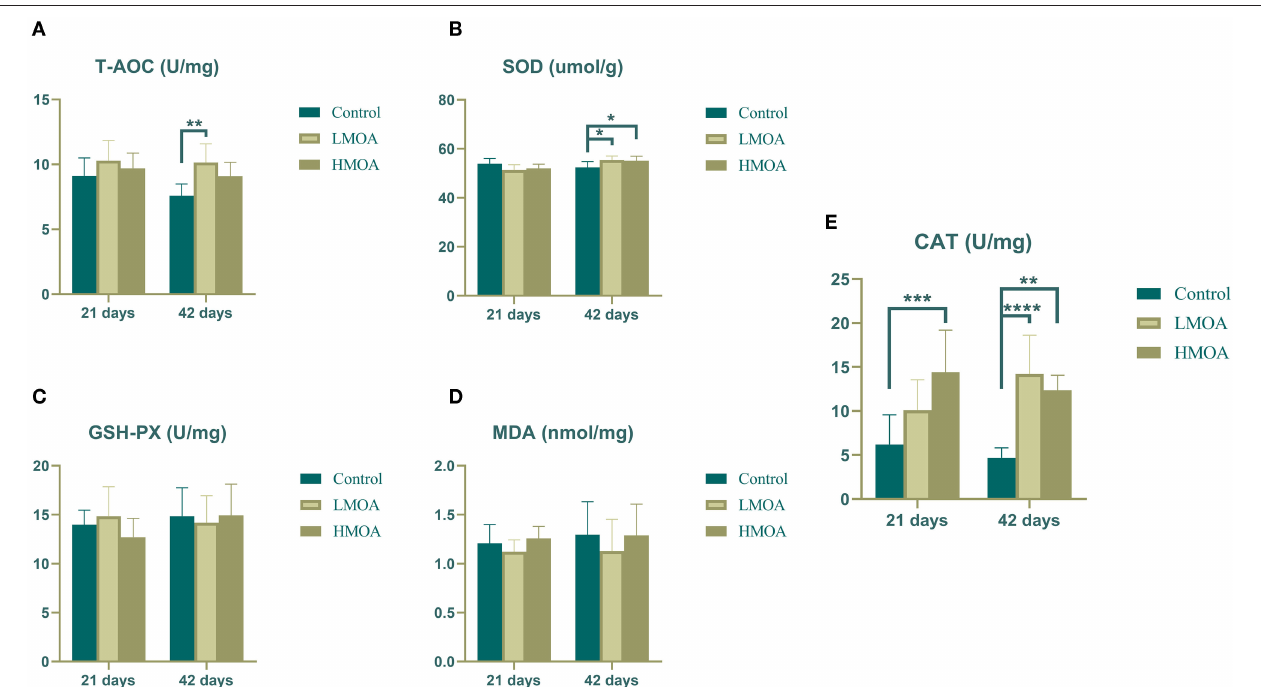
FIGURE 1 | The antioxidant enzyme characteristics of serum in 21 and 42 d-broilers as affected by dietary MOA supplementation. (A) Total antioxidant capacity (T-AOC), (B) Superoxide dismutase activity (SOD), (C) Glutathione peroxidase activity (GSH-Px), (D) Malondialdehyde (MDA), (E) Catalase activity (CAT). Control: a basal diet of corn-soybean meal with 0 mg/kg of mixed organic acid; LMOA: a basal diet with 3,000 mg/kg of mixed organic acids; HMOA: a basal diet with 6,000 mg/kg of mixed organic acids. Data are indicated as means ± SEM ( n = 8). Bar with the asterisk (*) level presented the degree of significant difference. * 0.01 < p < 0.05; ** 0.001 < p < 0.01; *** 0.0001 < p < 0.001; **** p <